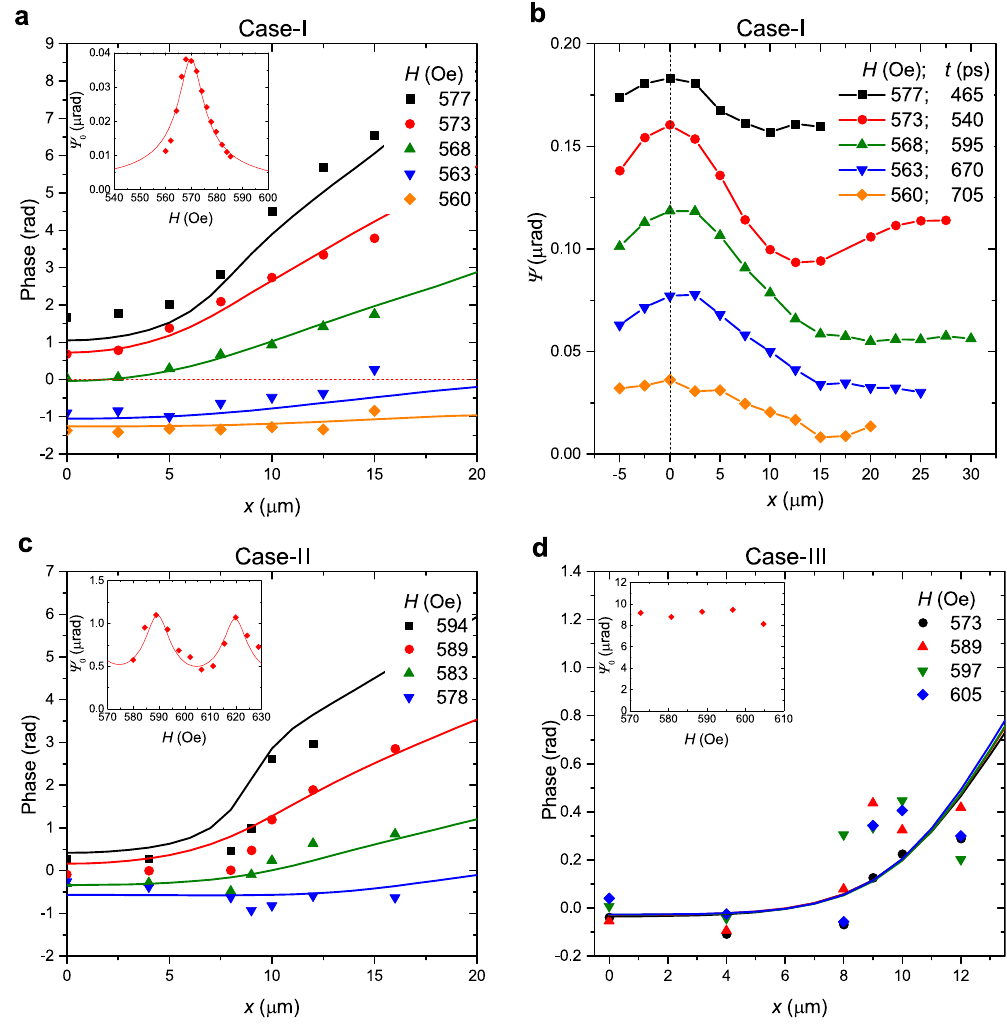
Figure 3. Influence of the external magnetic field on the phase and wavenumber of the spin waves optically generated by the 1GHz-laser in sample-A ( a,b ), and by the 80MHz-laser in sample-A ( c ), and sample-B ( d ). The spin waves are traced along the x -axis. ( b ) Distribution of the SW magnetization component parallel to the probe beam (measured by Faraday rotation, Ψ ) at the moments when it is maximal at x = 0. Insets: amplitude of the spin waves (measured by Faraday rotation, Ψ 0 ) at x = 0 versus external magnetic field. Experimental data are shown as dots while calculation results are presented by solid curves. For the calculations of the phase ξ ( x ), α = 4 × 10 − 3 for the sample-A ( a–c ) and α = 20 × 10 − 3 for the sample-B ( d ) are taken. For the calculations of the SW amplitude, α SW = 6.5 × 10 − 3 (insets in a and c